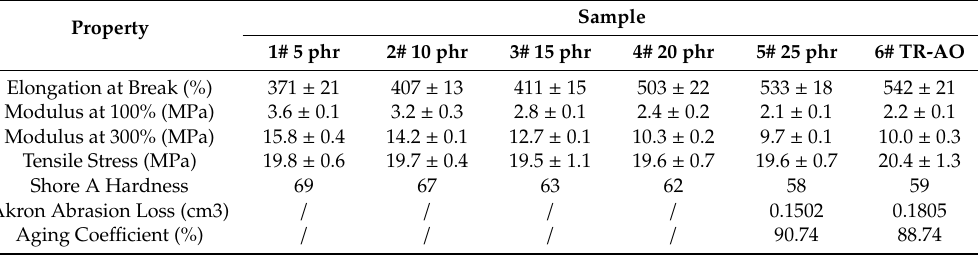
Figure 7. Stress-strain curves of tread rubber with di ff erent amounts of plasticizer.